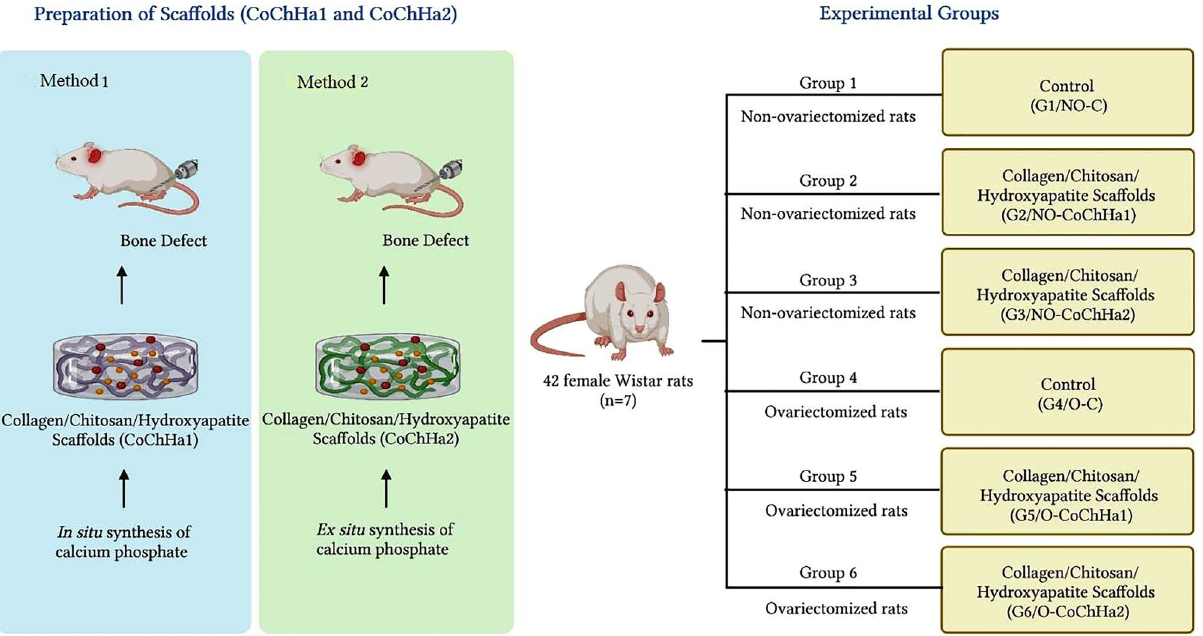
Figure 5. Schematic representation of the experimental design for formation of the experimental